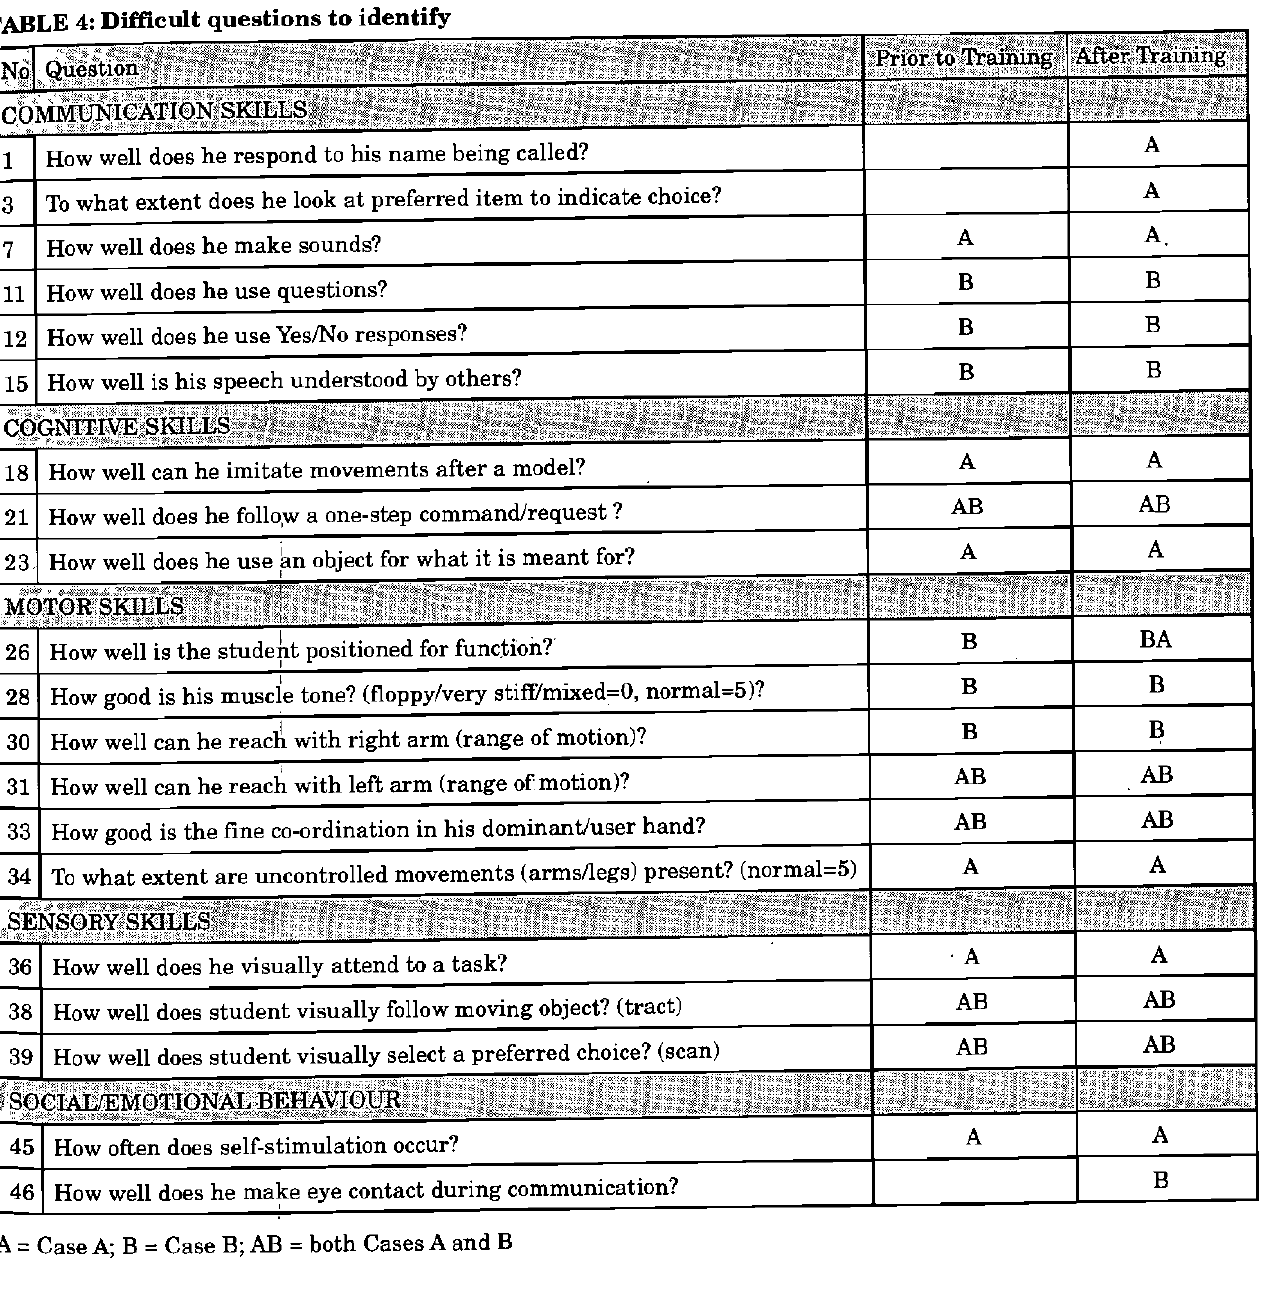
TABLE 4: Difficult questions to